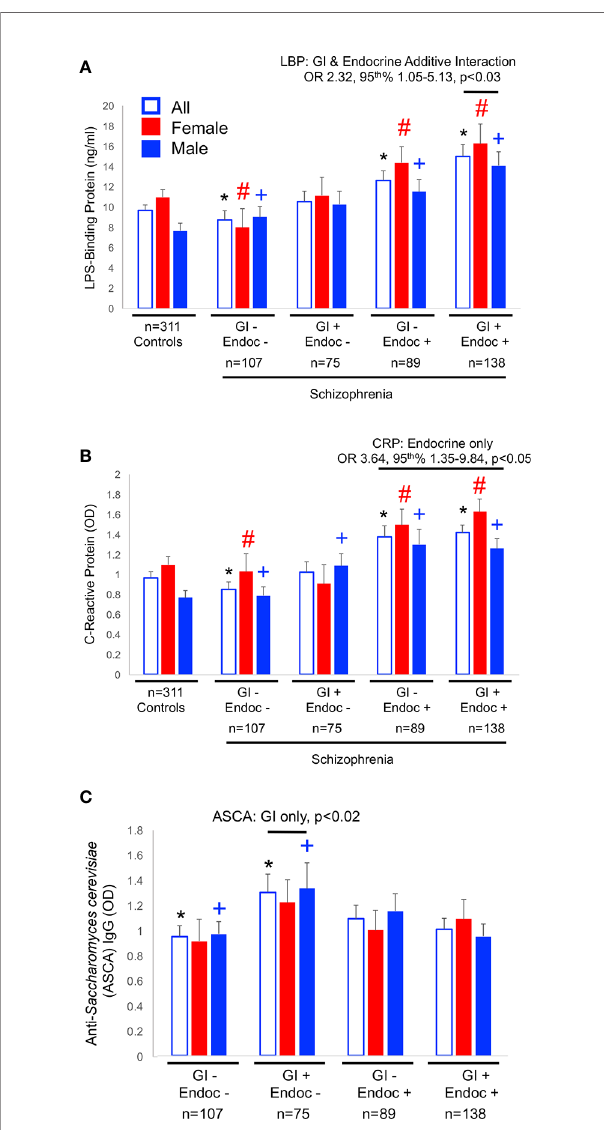
FIGURE 1 | Biomarker levels for LBP (A) , CRP (B) and ASCA (C) are shown. Signi fi cant differences in levels from univariate comparisons are marked with an asterisk (*) for all members, with a pound sign (#) for females and a plus (+) for males. Data for multivariate comparisons were signi fi cant for LBP and CRP. Signi fi cant odds ratios (OR) and 95 th % con fi dence interval (CI) are shown for LBP and CRP. LBP associations were a function of both GI and endocrine disturbances, CRP of endocrine only, and ASCA of only GI